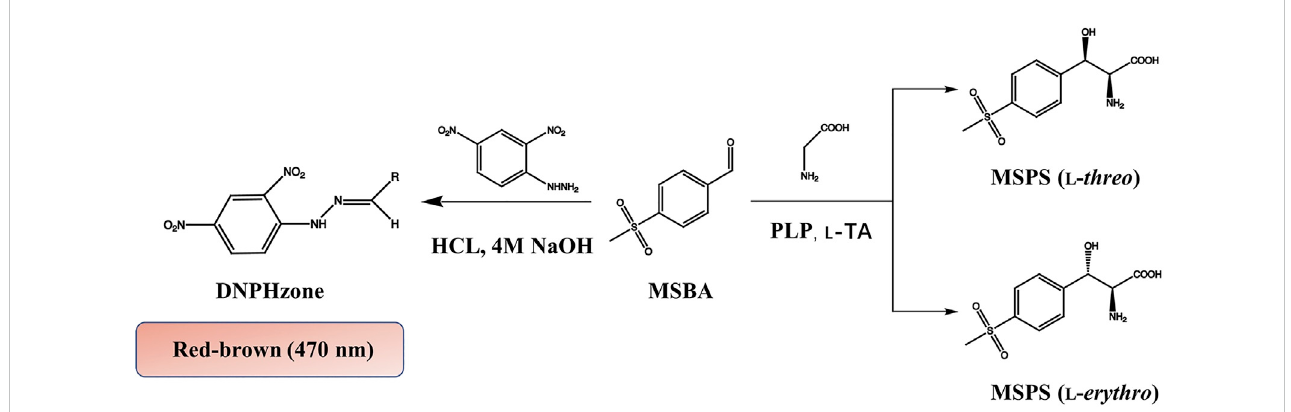
FIGURE 2 HTS colorimetric method for determining MSBA comsuption by L -PpTA.